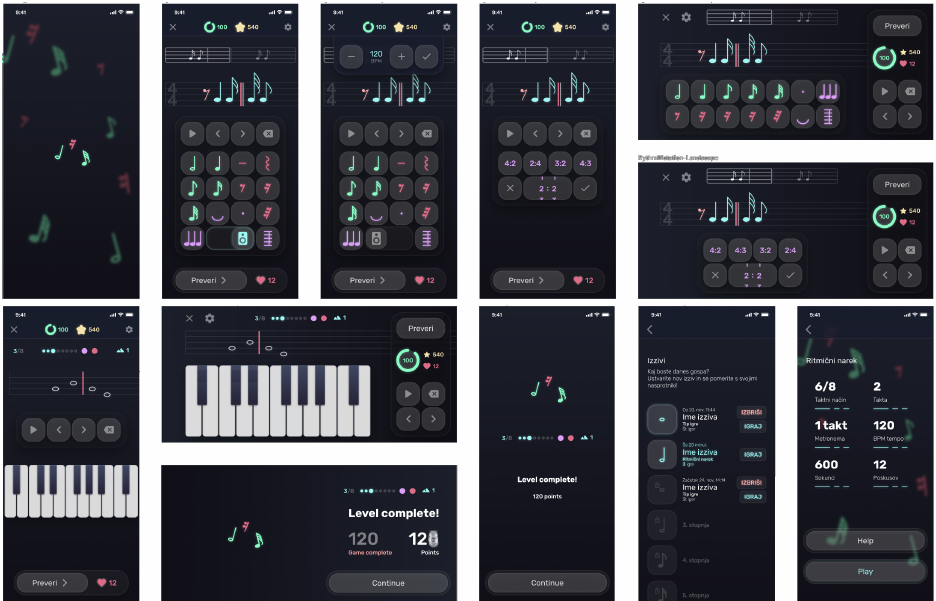
Figure 12. A design draft of a more modern layout for the Troubadour